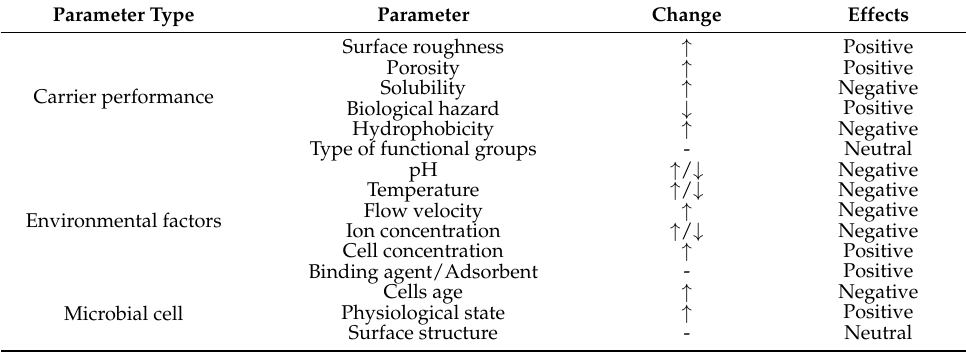
Carrier performance ↓ ↑ Negative Type of functional groups - pH ↑ / ↓ ↑ / ↓ Environmental factors ↑ Cells age ↑ Negative Physiological state ↑ Positive Microbial cell Surface structure - Neutral